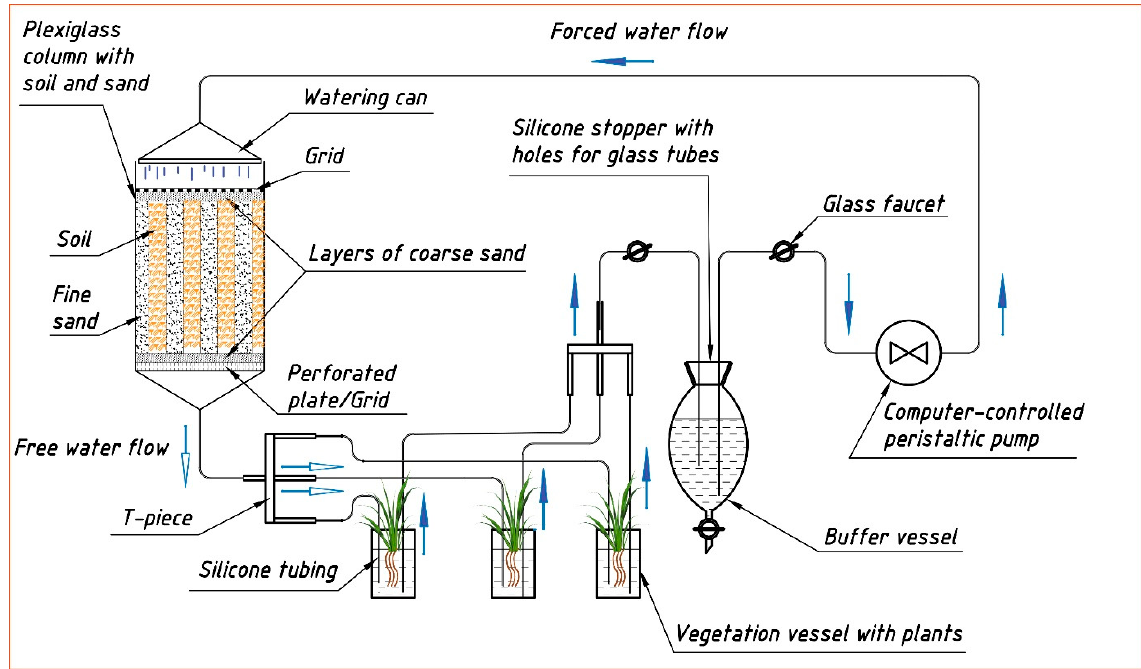
Figure 12. Structural and dynamic scheme of the stand used for studying the parameters of Zn( 65 Zn) migration in the soil–soil solution–plant system (opened blue arrow is designated to soil solution before vegetation vessels (input), filled blue arrow – after them (output)).